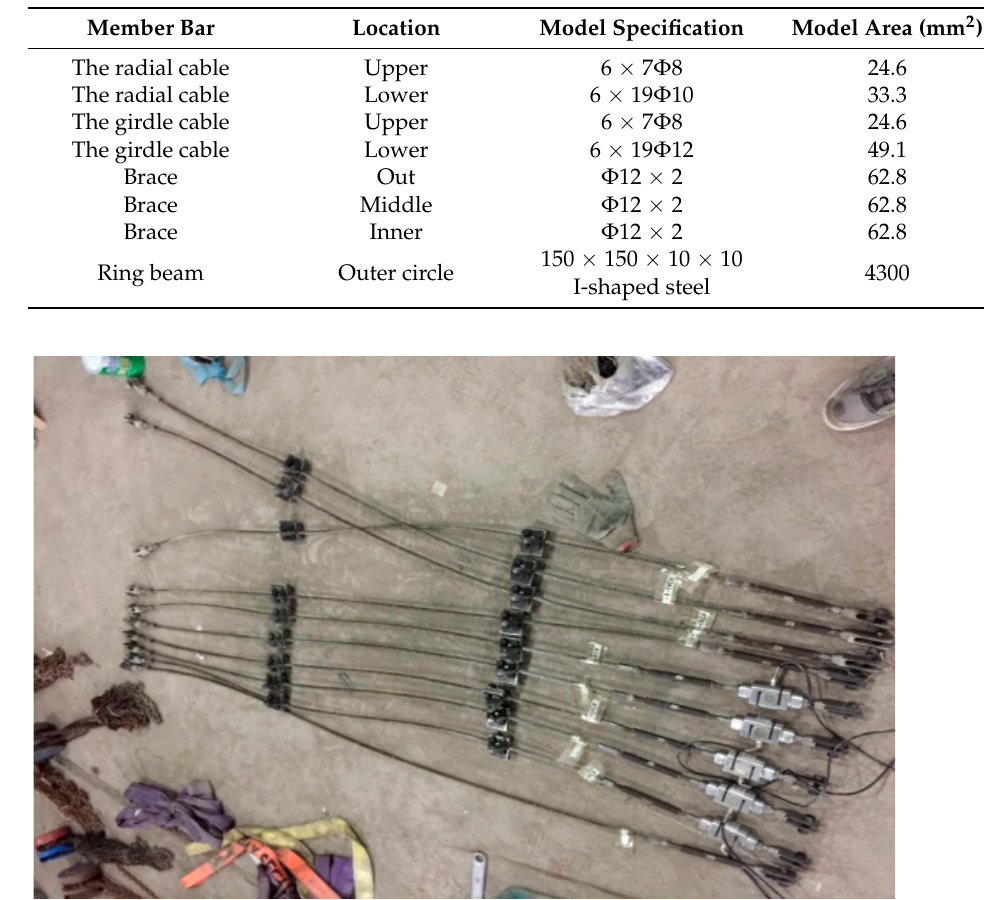
Figure 5. The diagram of the cable structure. Table 1. Model material selection specifications.